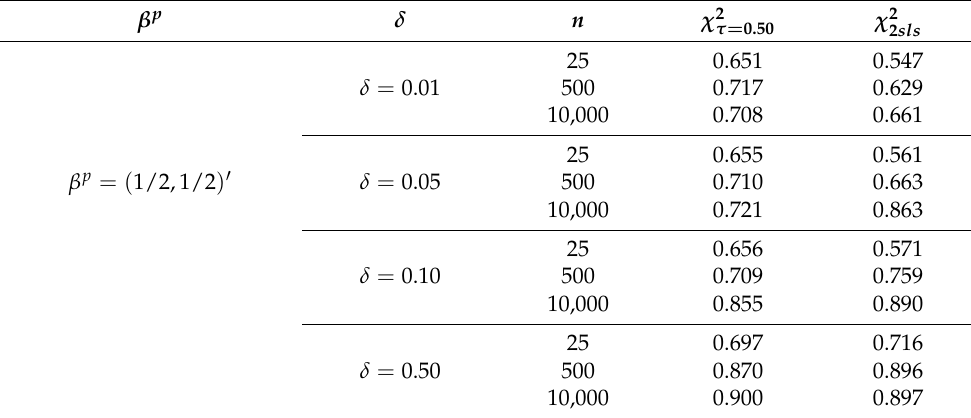
Table A1. Coverage probabilities for confidence regions created from the χ 2 statistic with τ = 0.5 and the corresponding values from 2SLS estimation. The simulated model is given by Equations (1), (2), (4) and (12) with k = 2, m = 4, z i ∼ iid N ( 0, I 4 ) , and β 0 = ( 0,0 ) (cid:48) . The models differ with respect to priors ( β p ), strength of the instrument ( δ ), and sample size ( n ). Each model is simulated 10,000 times and the test performed with a size of